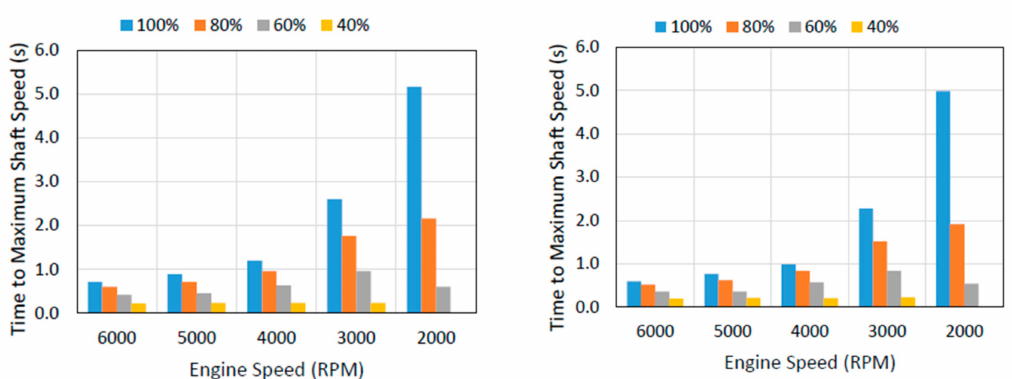
Figure 31. Comparison between radial ( left ) and axial ( right ) turbines time to maximum shaft speed at di ff erent engine operating conditions.